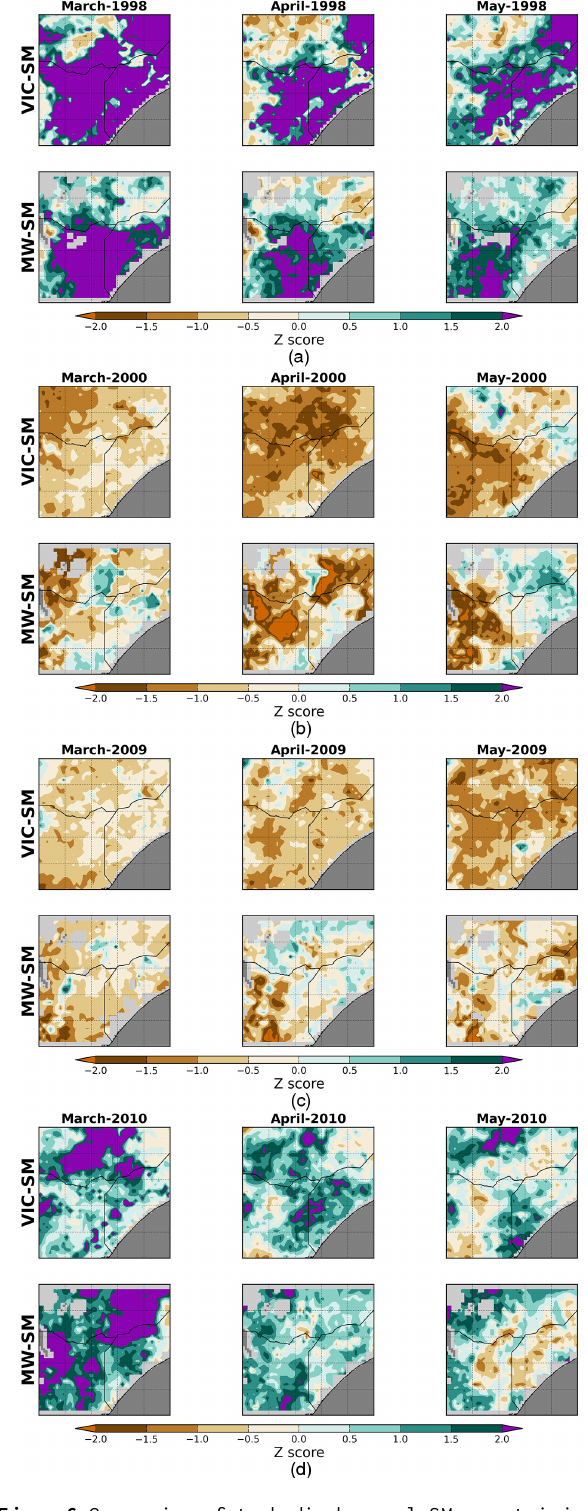
Figure 6. Comparison of standardized anomaly SM a posteriori es- timates (VIC SM, sum of moisture in top two layers) and ECV mi- crowave soil moisture (MW SM) for the March–May season of the years (a) 1998, (b) 2000, (c) 2009 and (d)